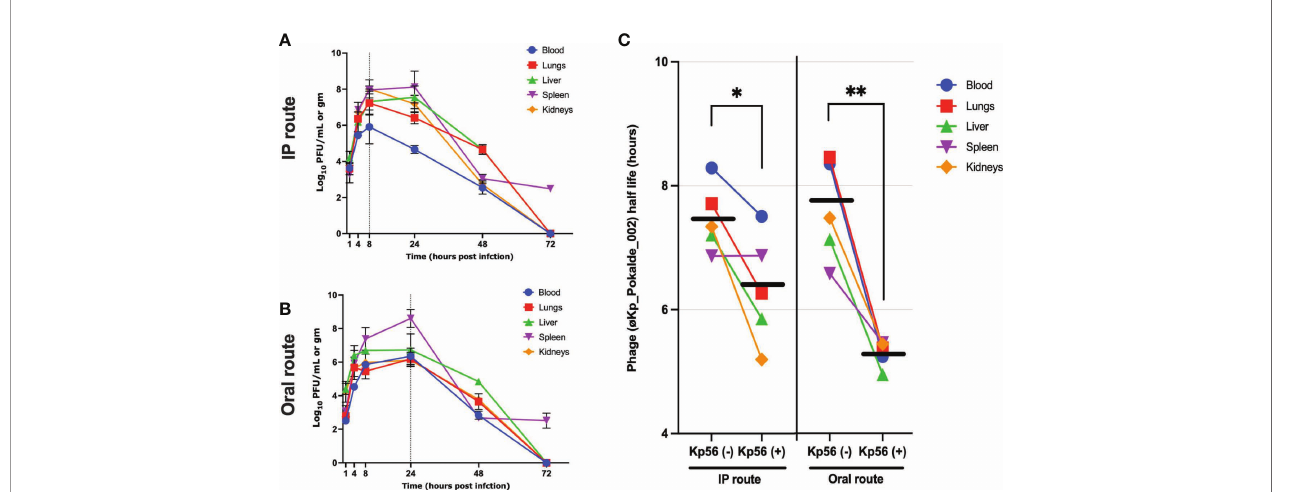
FIGURE 3 | Pharmacokinetics of øKp_Pokalde_002 in vivo and half-life of øKp_Pokalde_002 in the presence and absence of host bacteria Kp56 in mice when administered via IP and oral routes. The phage concentration in log 10 PFU/ml in blood, lungs, liver, spleen, and kidneys after 1, 4, 8, 24, 48, and 72 h in Kp56 treatment group after administration of phage via IP (A) and oral (B) route (200 µl of ~1 x 10 8 PFU/ml). The dotted vertical line indicates T max . (C) The overall elimination half-life of øKp_Pokalde_002 is lower when host bacteria are present, signifying rapid clearance of phage from circulation in the presence of susceptible host. The individual data point represents an average from three replicates from three mouse. The horizontal line represents the grand